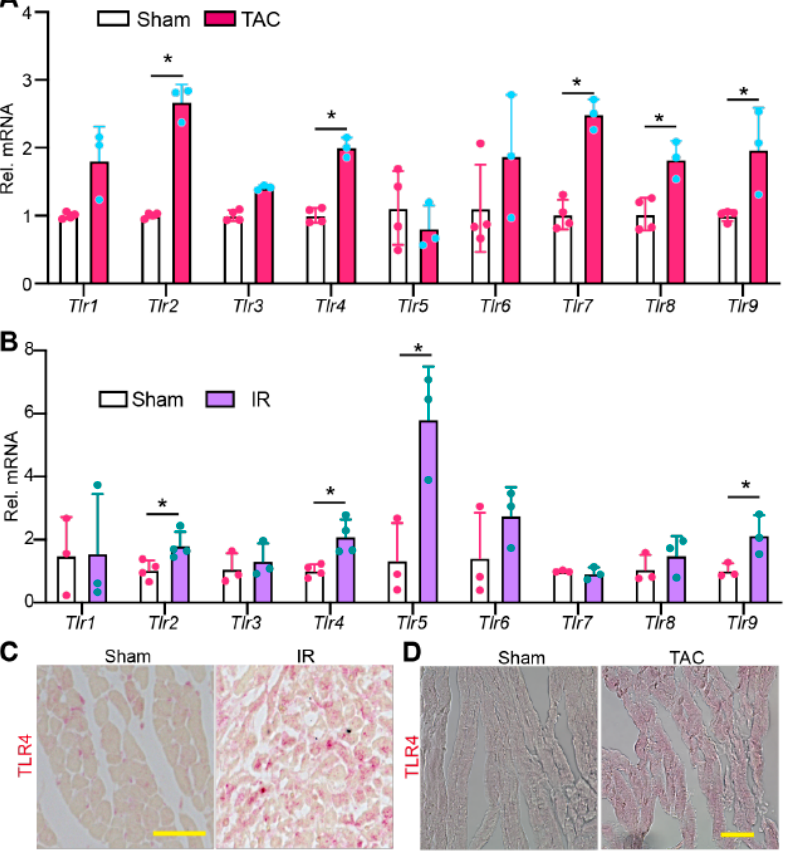
Figure 2. The expression pattern of TLR genes in stressed hearts. qRT-PCR measurement of TLR genes in pressure overload stressed hearts. 6–8 weeks old mice were stressed with TAC (transverse aortic constriction) surgery for ten days before being sacrificed for cardiac gene expression analysis. ( B ). qRT-PCR measurement of TLR genes in ischemia-reperfusion (IR) stressed hearts. Gene expression level was normalized to Gapdh . ( A , B ), student t -test, *, p < 0.05. n = 3–4. ( C , D ). Representative images of myocardium immunostained for TLR4. Scale bar = 50 µm. ( B , C ), hearts were collected for analysis two days after IR surgery.